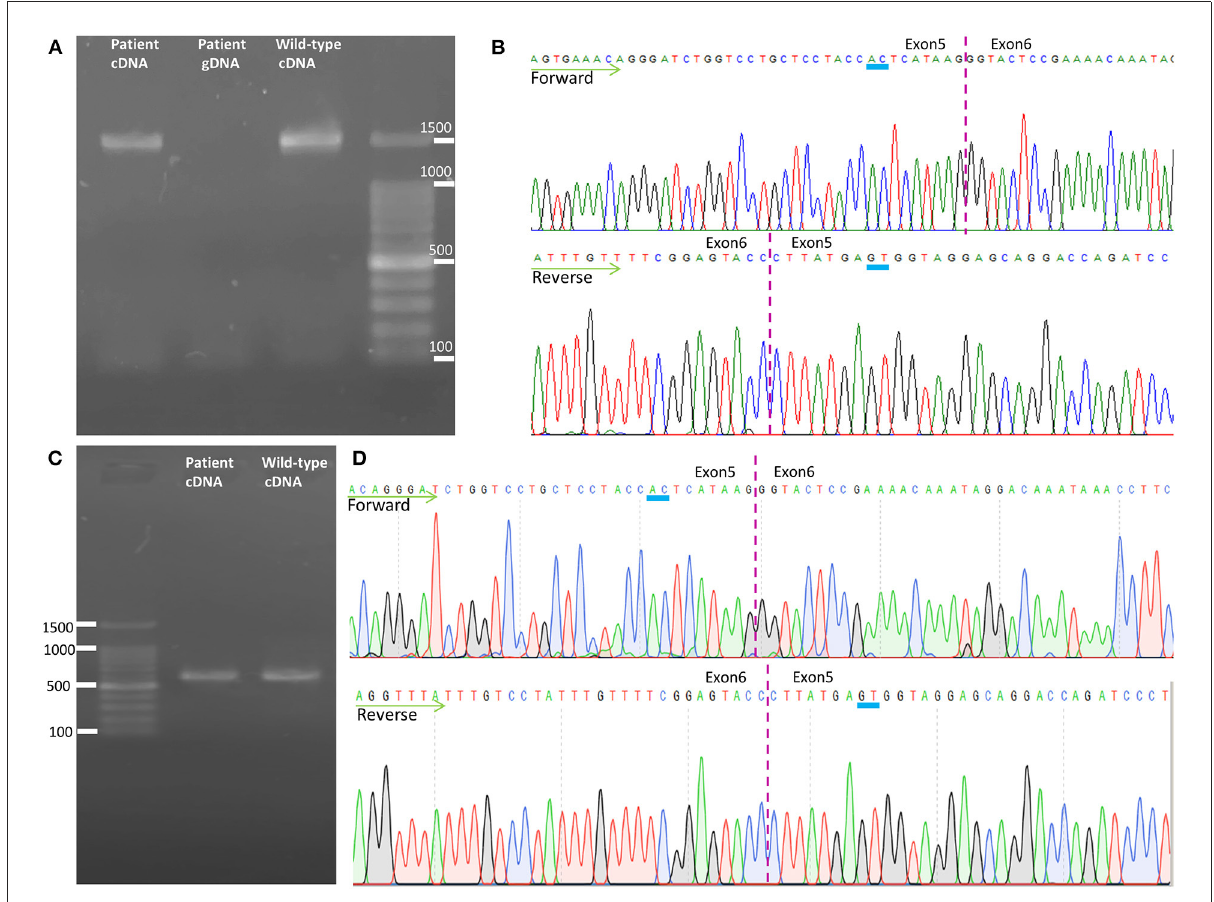
FIGURE3 Transcription analysis of spastin in lymphoblast cell lines. (A) Agarose gel electrophoresis of the long-range RT-PCR products revealed only the cDNA fragment of 1,494 bp corresponding to the predicted canonical transcripts in both the patient and the control. (B) Sanger sequencing of long-range RT-PCR products revealed only the canonical transcript in the proband, which was reconfirmed on sequencing with a reverse primer. The transcript with the frameshift variant was not detected. (C) Agarose gel electrophoresis of the shorter RT-PCR products revealed only the 603 bp band expected in both the patient and control. (D) Sanger sequencing of the shorter RT-PCR products in both directions identified only canonical transcripts in the patient. cDNA, complementary DNA; gDNA, genomic